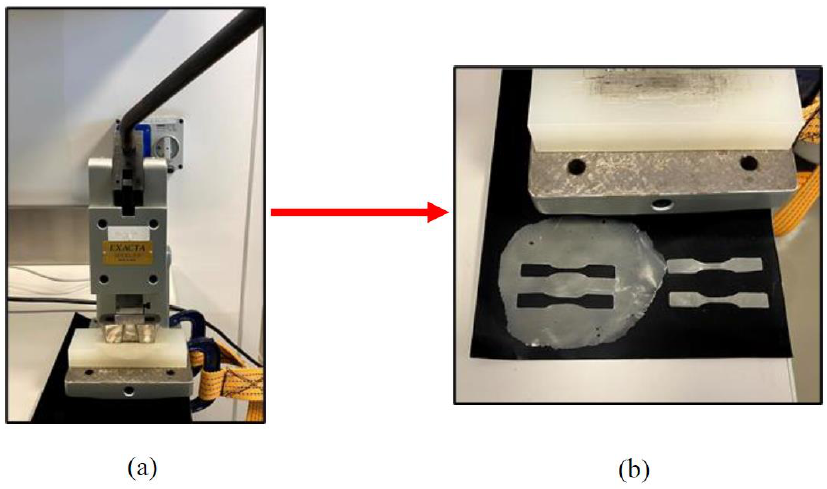
Figure 8. ( a ) Blanking machine; ( b ) Dumbbell shape samples after blanking process.